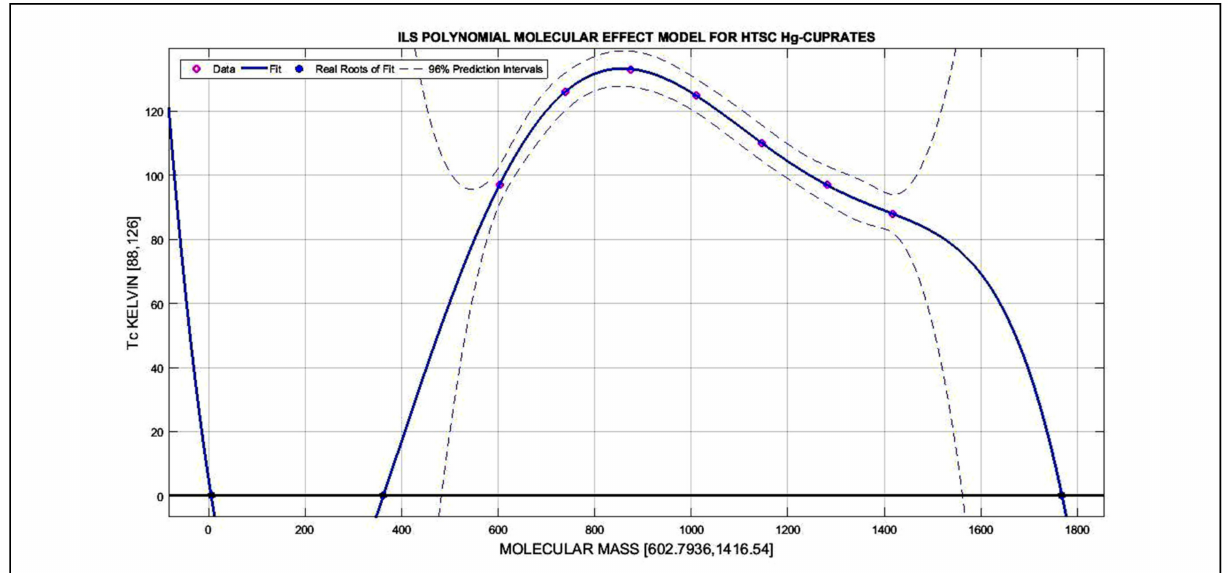
Figure 9. Molecular effect model with ILS 5-degree polynomial fit with 96% confidence intervals. Generally, Tc matches a parabolic curve when the molecular weight increases. At lower values of molecular weight, there is a low accuracy of approximately 250 toward lower molecular weight magnitude